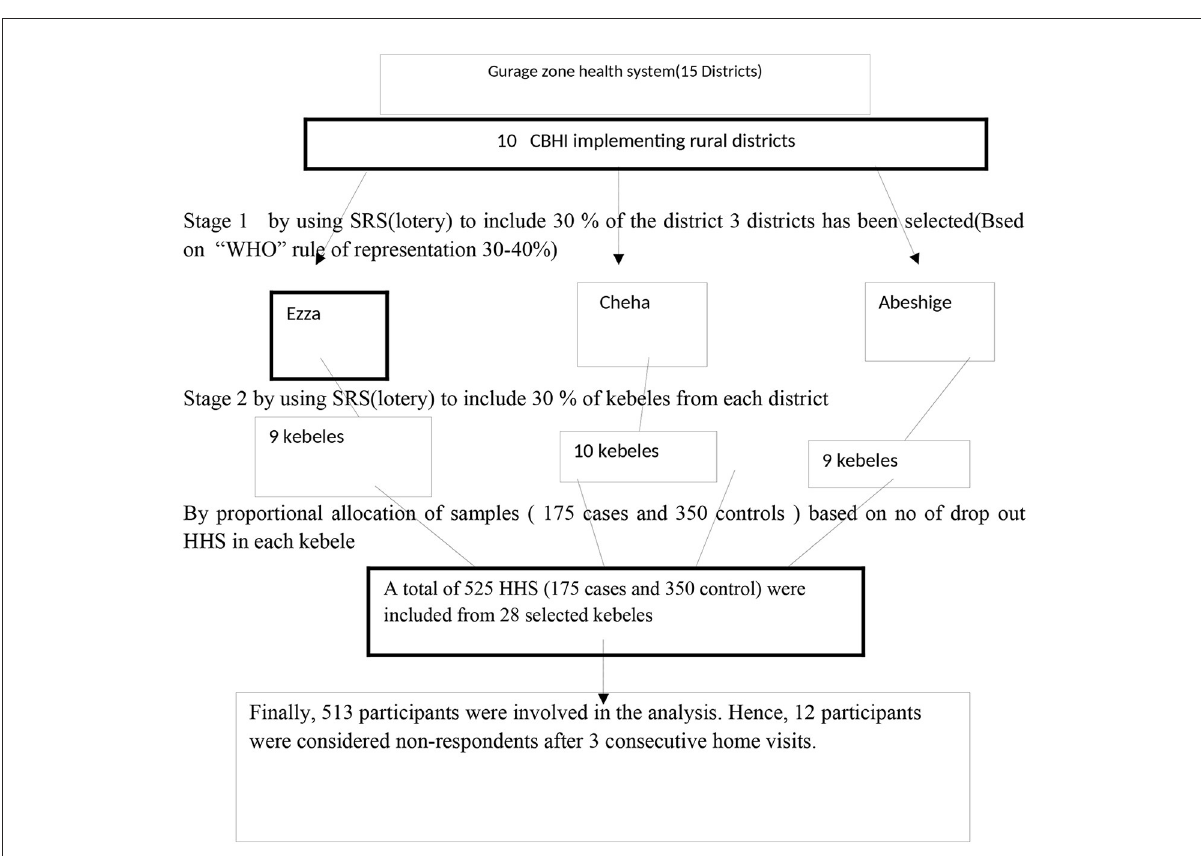
FIGURE1 Schematic presentation of the sampling procedure for a study on factors influencing dropout of households from community-based health insurance, that clarifies the sample enrolled and dropout in each phase in southern Ethiopia, 2021.